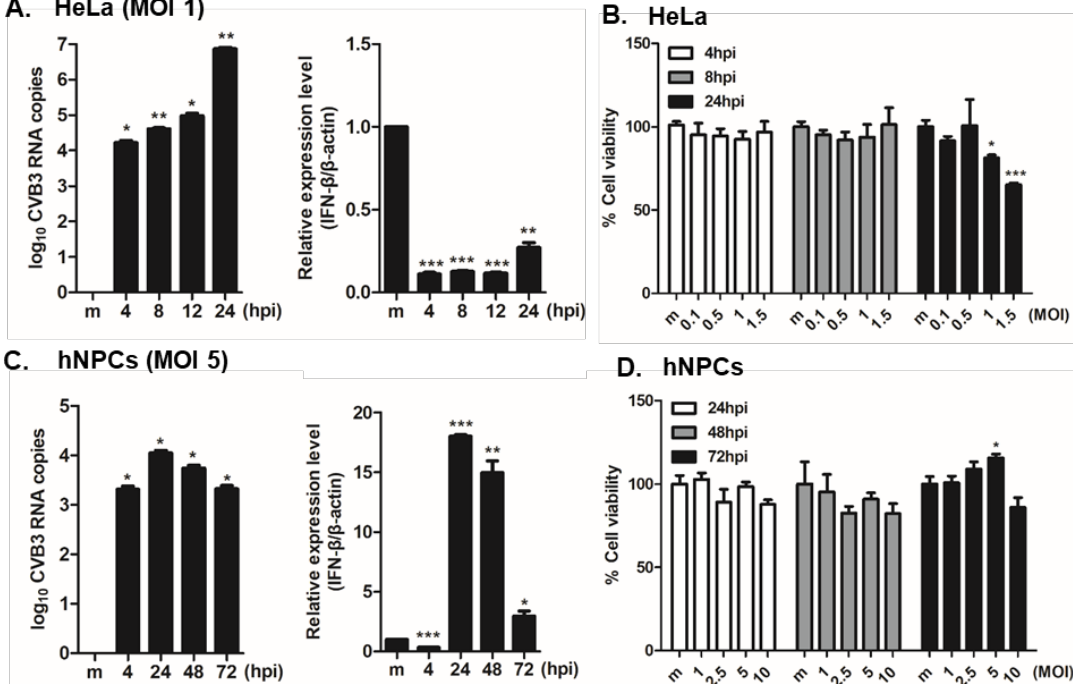
Figure 1. Coxsackievirus B3 (CVB3) efficiently replicates in human neural progenitor cells (hNPCs) and causes minimal cytotoxicity. HeLa cells and hNPCs were infected with CVB3 at MOI of 1 or 5 for the indicated times. ( A , C ) RT-PCR was performed to measure CVB3 copy number and IFN- β mRNA levels. The expression of viral RNA copies was calculated in relation to the expression level of β -actin mRNA. *, p < 0.05; **, p < 0.01; ***, p < 0.001, compared with mock-infected cells. ( B , D ) At the end of the incubation period, cell viability was determined using CellTiter Glo assays. Each value represents the mean ± SEM ( n = 4).